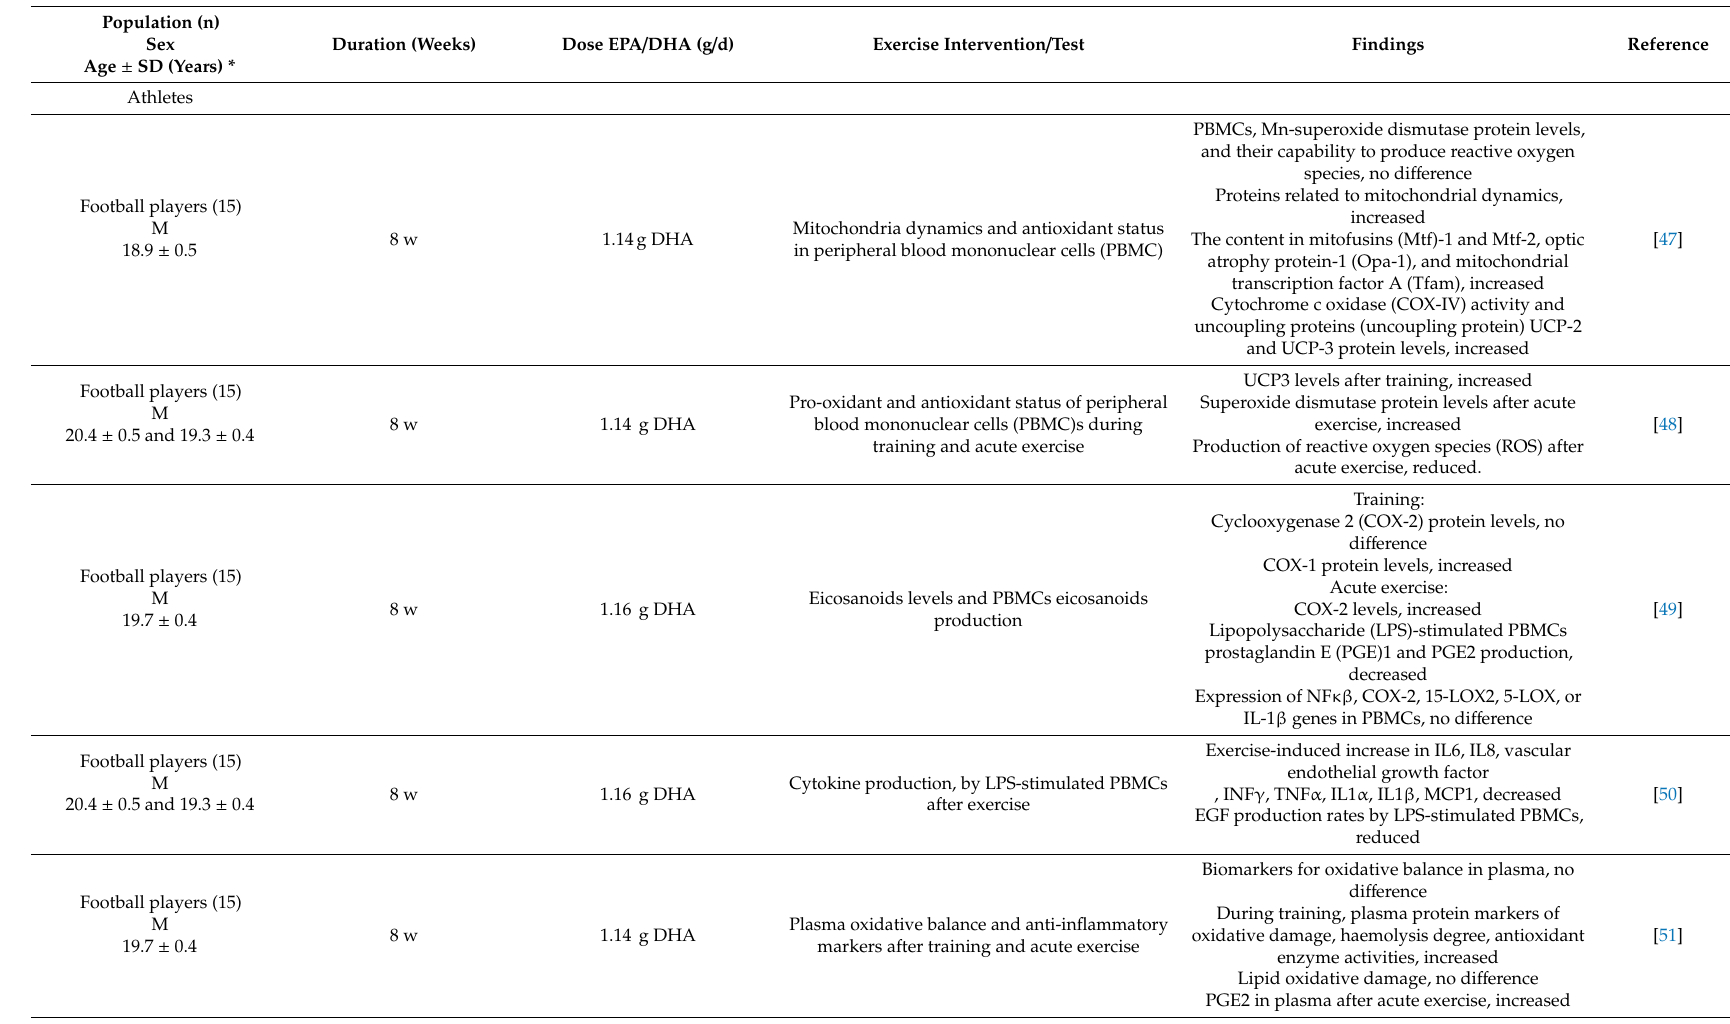
Table 2. E ff ects of EPA / DHA supplementation with a focus on recovery-related outcomes in athletes and